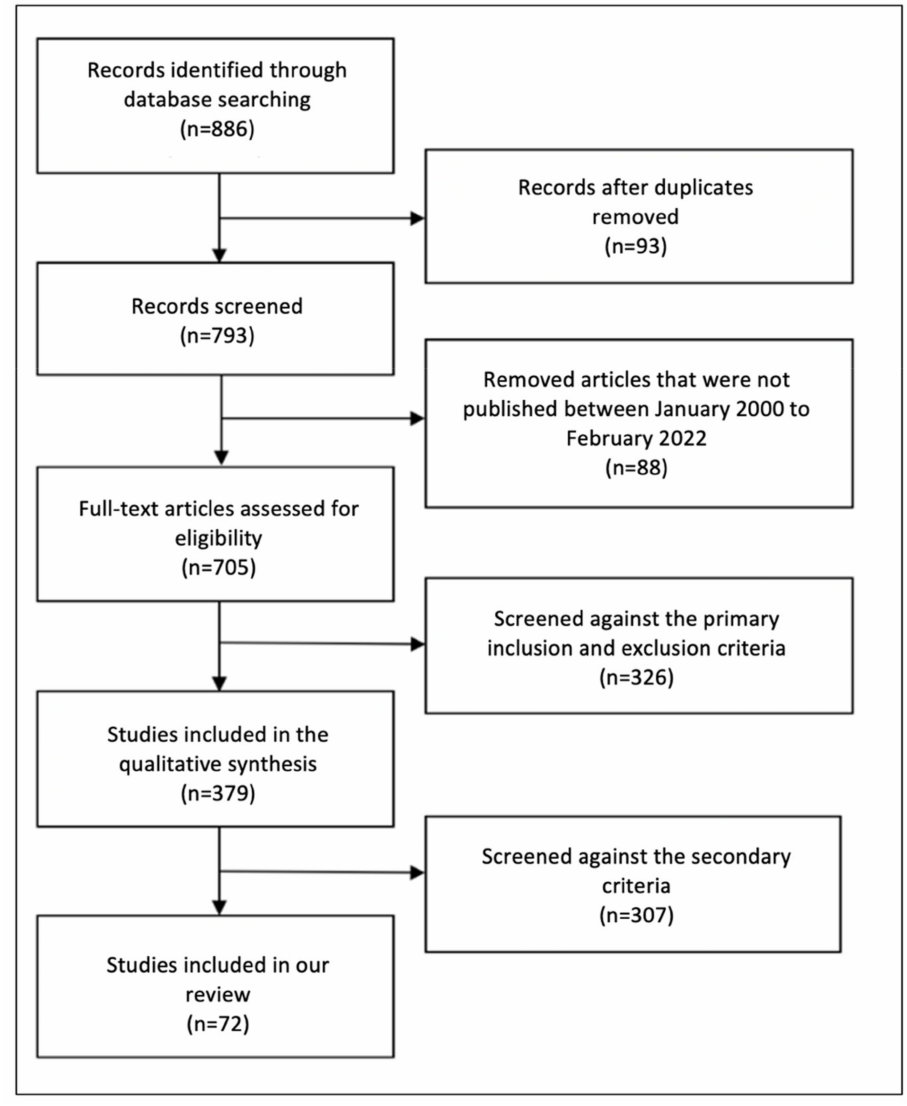
Figure 3. The PRISMA selection process of relevant